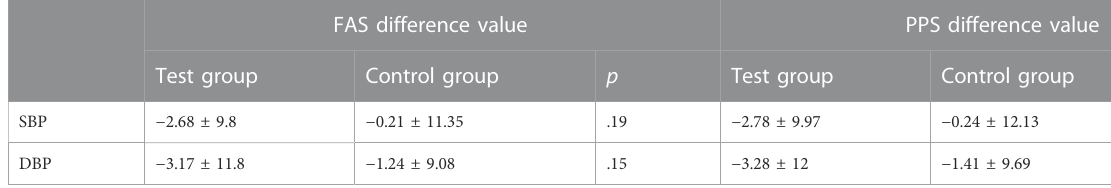
TABLE 5 Changes in home BP from baseline to 4 weeks (FAS, PPS).